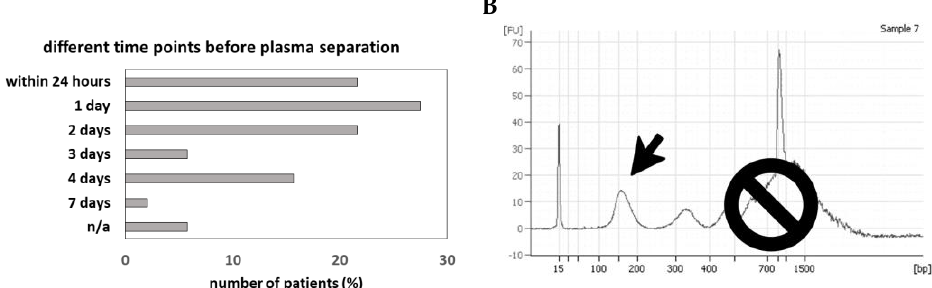
Figure 1. Delay in plasma separation. Fifty-one patients were enrolled in the study of which plasma preparation was performed at different time points after blood withdrawal. For all samples plasma DNA was isolated. ( A ) Storage time of whole blood in K 2 EDTA tubes at room temperature before plasma isolation. ( B ) Contamination of ctDNA (arrow) with high molecular genomic DNA (prohibition sign) was analyzed using an Agilent Bio-Analyzer.